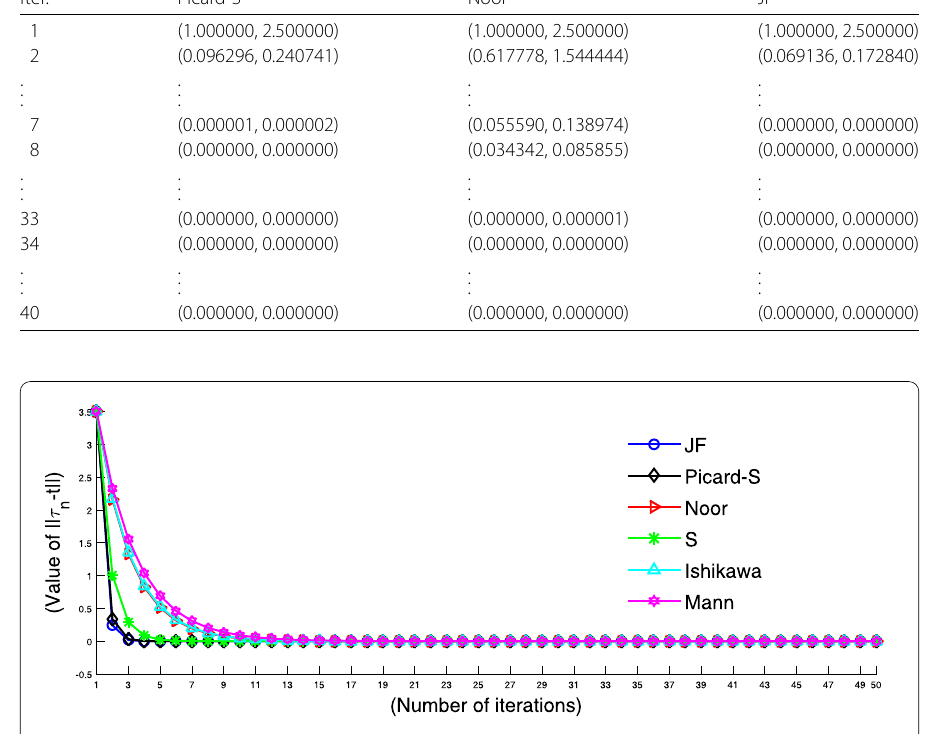
Table 2 Computational table of different iteration processes Iter.